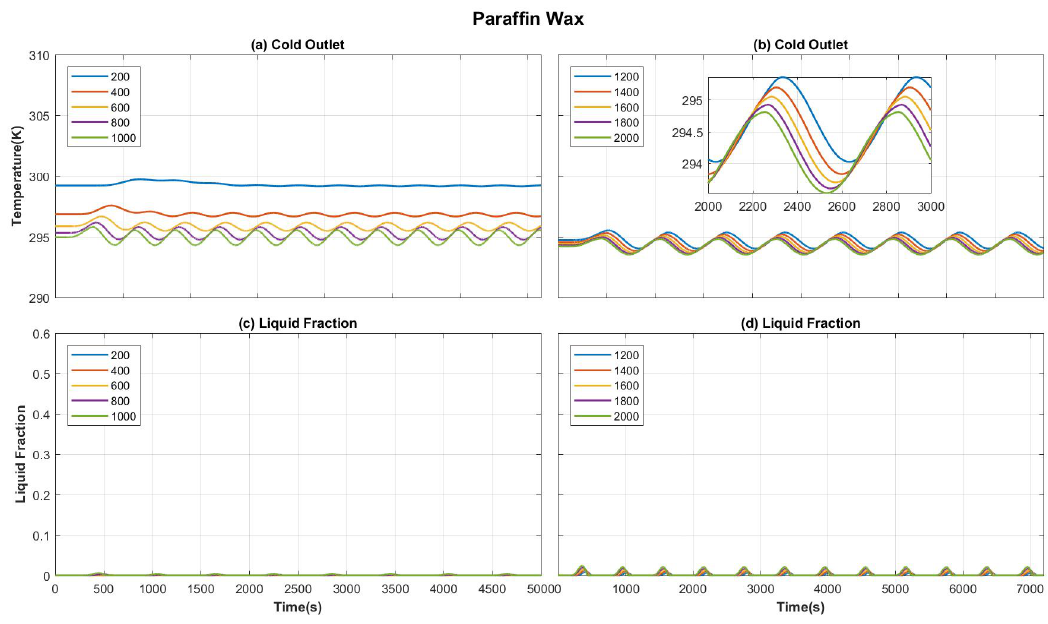
Figure 9. Cold outlet temperature and liquid fraction for paraffin wax ( T s = 319.15 K, T l = 320.15 K) at Reynolds from 200 to 2000. Reynolds 200–1000 on the left ( a , c ) and 1200–2000 on the right ( b , d ). The paraffin wax is shown to only phase change a small amount at all Reynolds numbers, the small amounts do not noticeably affect the outlet temperature and the results are very similar to myristic. Despite the phase change temperature being close to the average temperature of the oscillating hot stream, the material is not very active demonstrating the difficulty in selecting an appropriate phase change